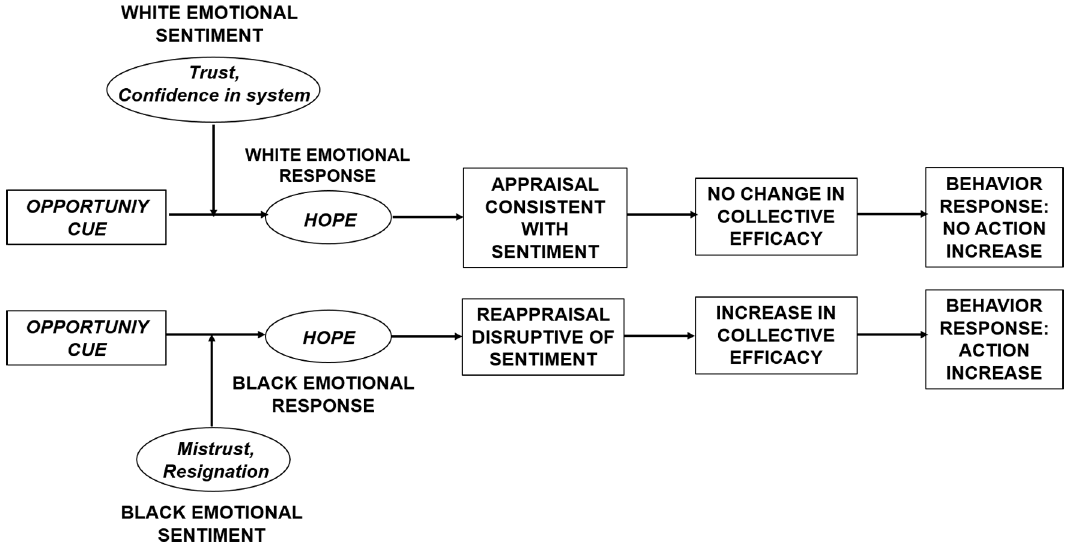
Figure 1. Racial Emotion Regulation Model—Illustrating the effect of hope on group efficacy and